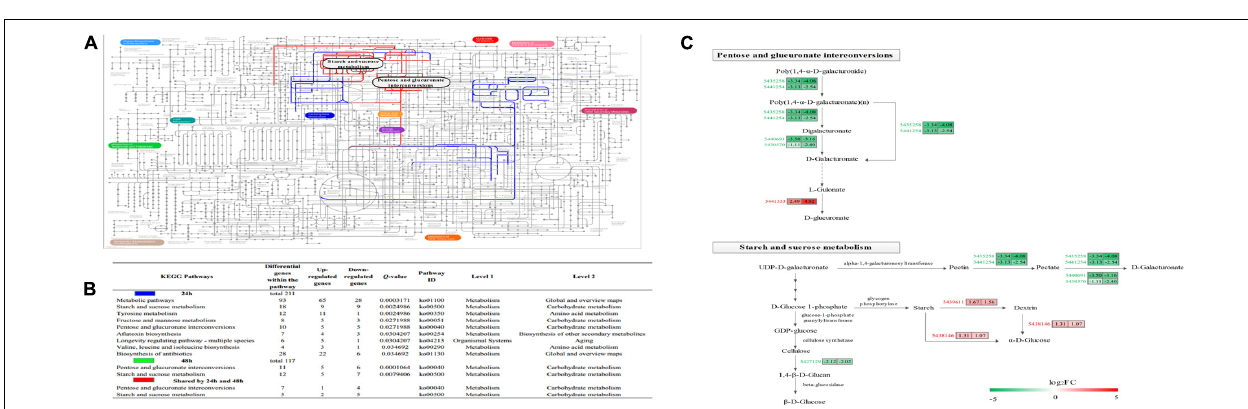
participated in pectin degradation and were downregulated in the treatment